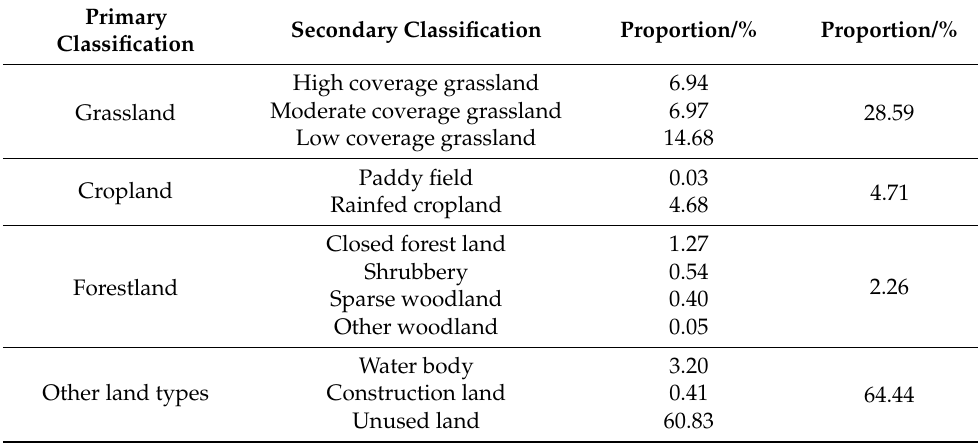
Figure 3. Spatial correlation between NDVI and SPI/SPEI/SSMI. Table 1. Vegetation types and area proportions in